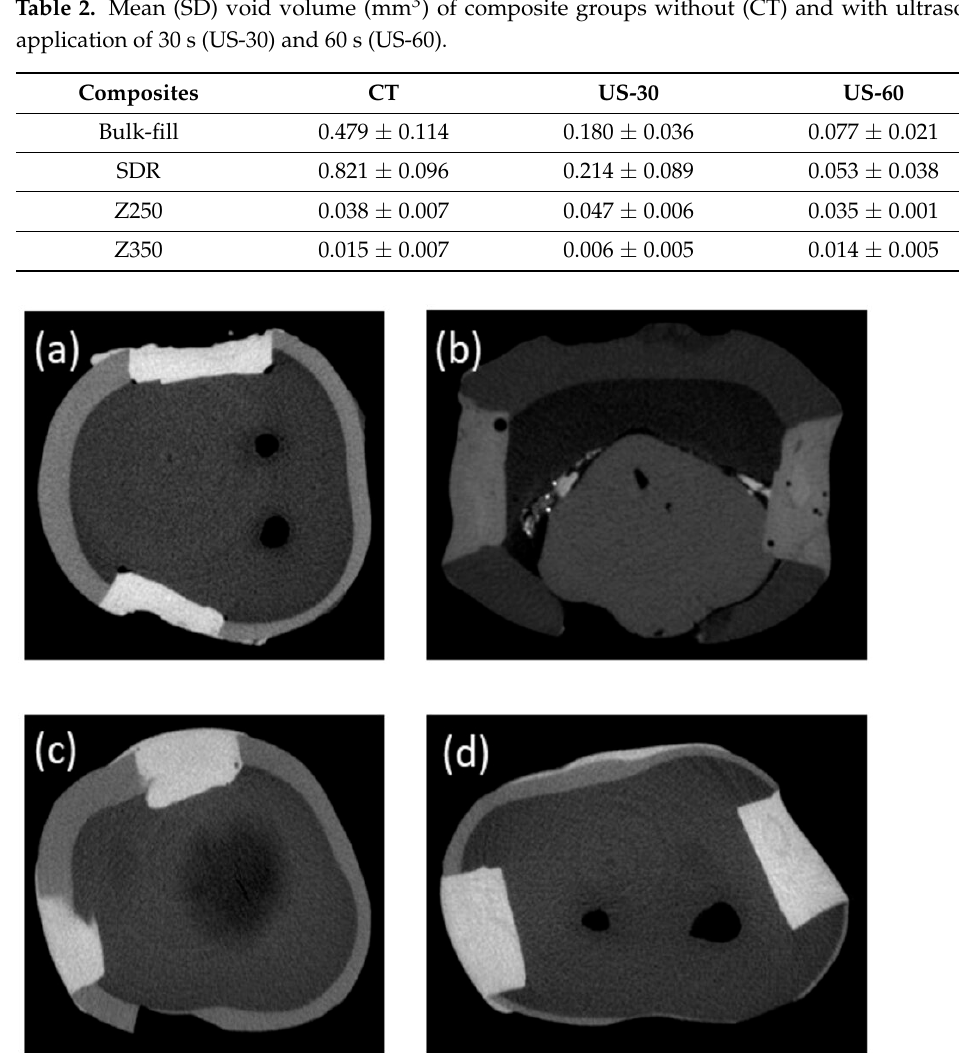
Figure 8. Cluster analysis of Filtek Bulk-fill composite showing uncured and cured at spectral range